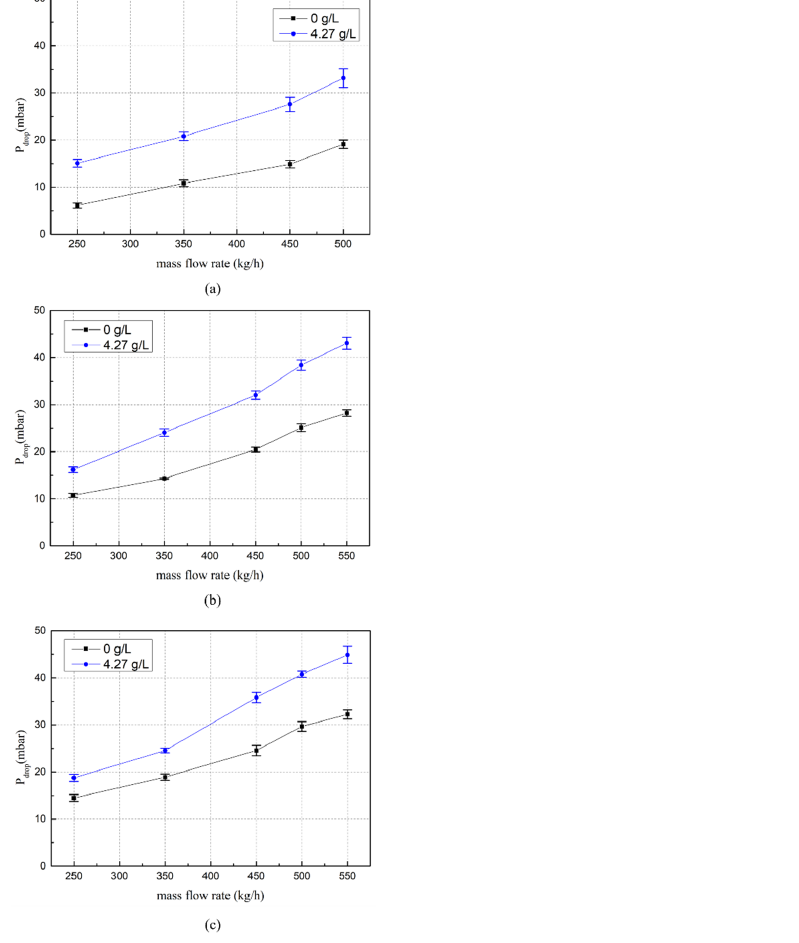
Figure 4. Differential pressure history at DPF with PM load of 4.27 g/L according to exhaust mass flow rate and exhaust temperature: ( a ) 200 °C; ( b ) 300 °C; ( c ) 400 °C.